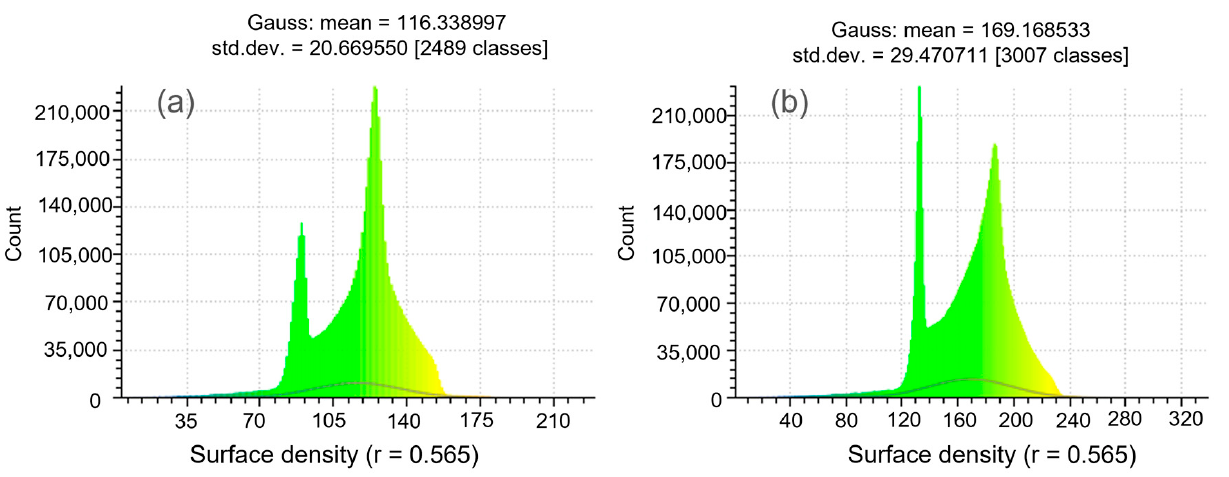
Figure 9. Histogram of surface density (pts / m 2 ) with r = 0,565 of ( a ) case A and ( b ) case